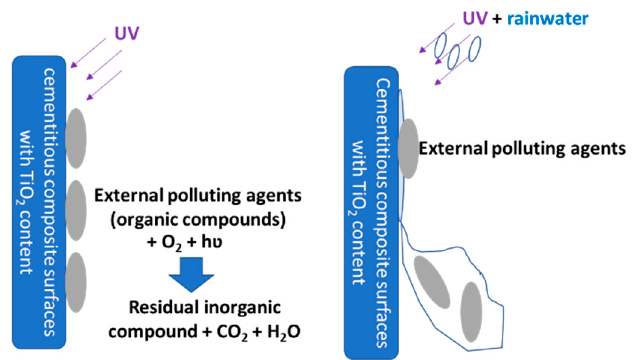
Figure 1. Schematic representation of the self-cleaning capacity by the cumulation of the two mechanisms: the process of photocatalytic oxidation of organic substances (left) and facilitating the removal of foreign substances by increasing surface hydrophilicity (right).